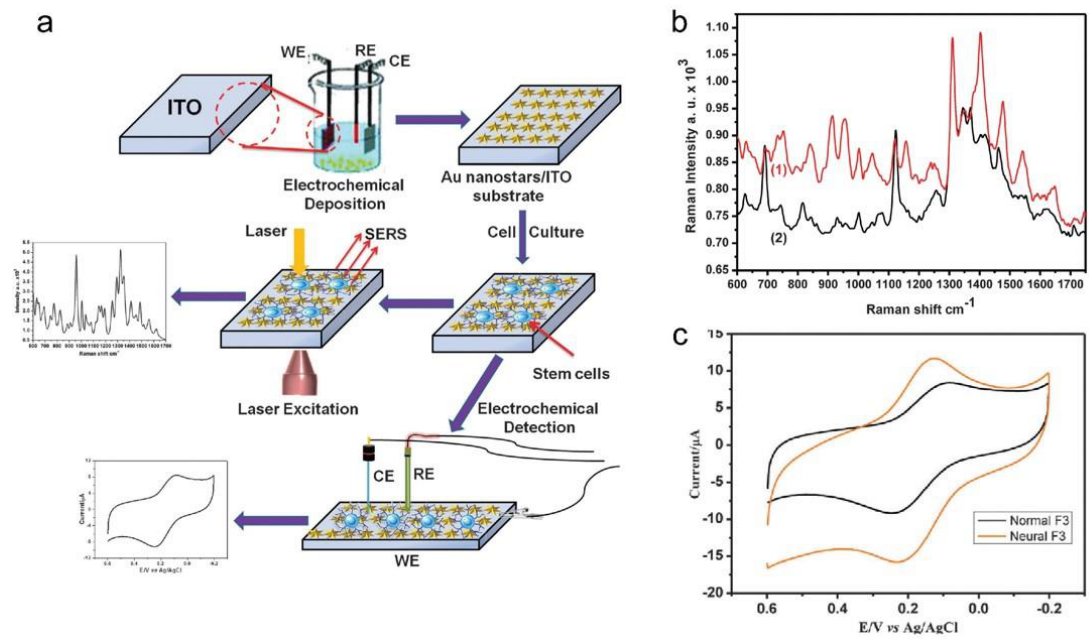
Figure 4. ( a ) Schematic diagram showing the spectro-electrochemical-based neural stem cell differentiation monitoring sensor on a gold nanostar array; ( b ) Raman spectrum for (1) undifferentiated and (2) differentiated HB1.F3 cells within the range of 600 cm − 1 to 1750 cm − 1 ; ( c ) cyclic voltamogram for differentiated and undifferentiated HB1.F3 cells. (Modified from Ref. [52] with permission, Copyright 2015 The Royal Society of Chemistry, London, UK).